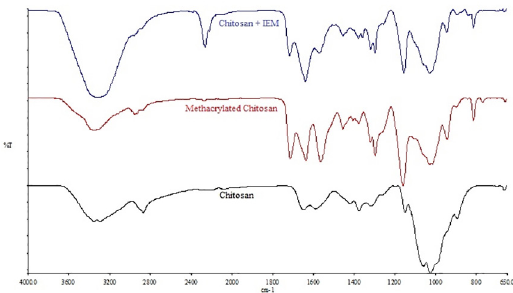
Figure 1: ATR-FTIR spectra of chitosan and methacrylated chitosan.